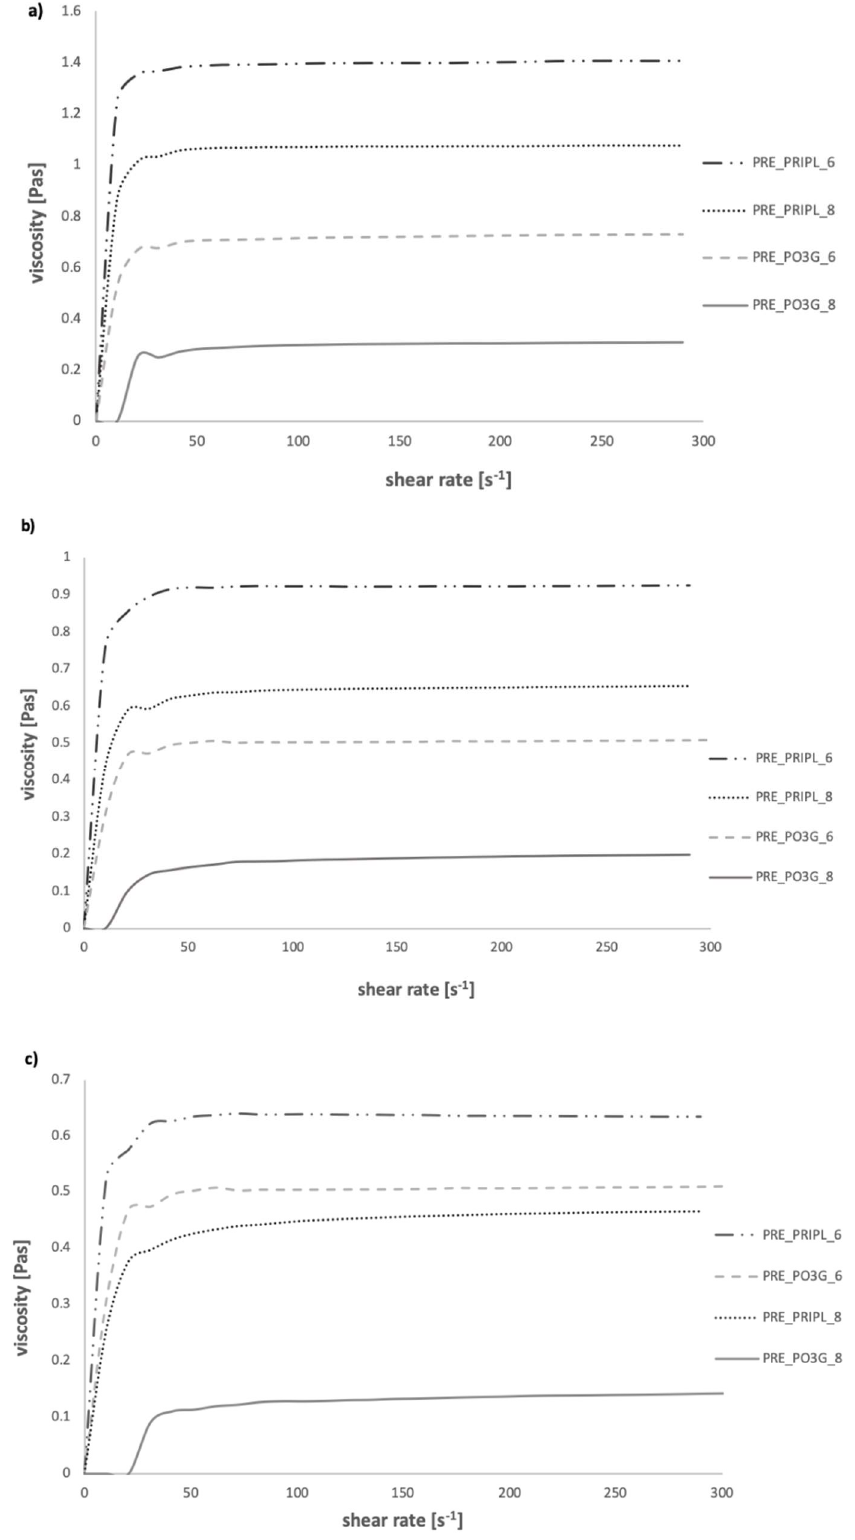
Figure 5. Viscosity curves of the synthesized bio − based polyols at ( a ) 60 ◦ C, ( b ) 70 ◦ C, ( c ) 80 ◦ C.